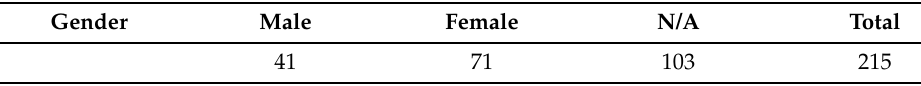
Table 4. Statistics about the gender of the volunteers.